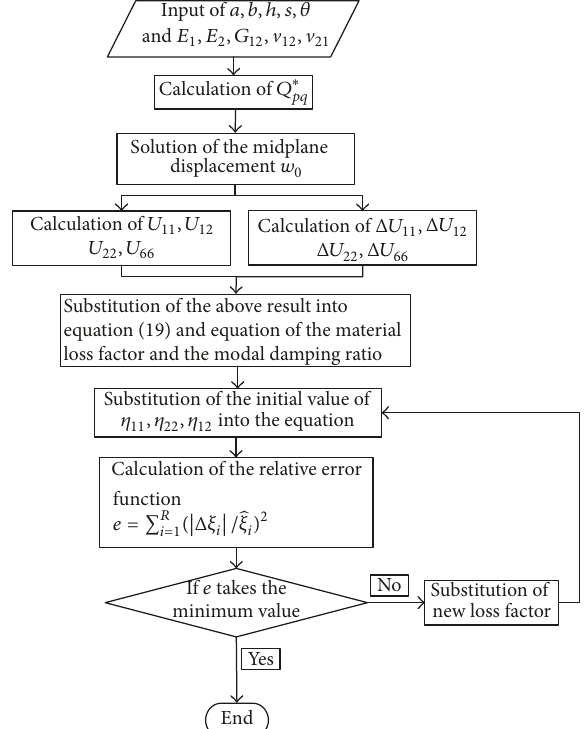
Figure 2: Identification process of loss factor of fiber-reinforced composite thin plate based on complex modulus